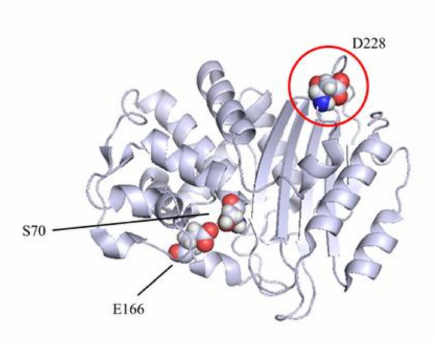
Figure 1. Ribbon representation of the KPC-3 enzyme. Molecular modelling was performed by PyMOL version 2.3 (PDB code: